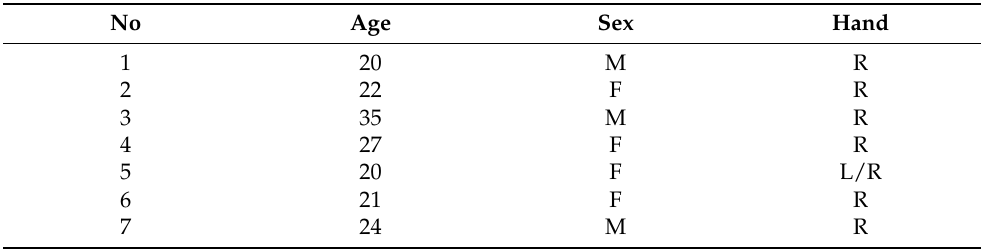
Table 2. Specification of the group selected for further analysis which takes into account age, gender and whether the person is right- or